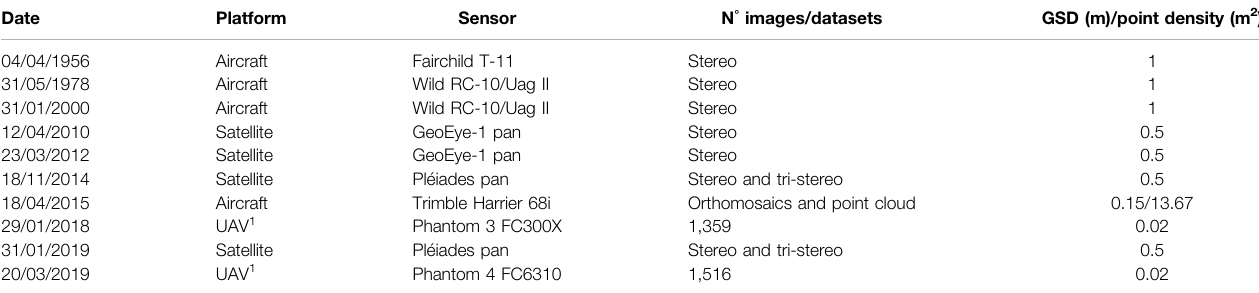
TABLE 1 | Available remote sensing imagery for the study area between 1956 and 2019. Pan refers to the panchromatic bands in GeoEye-1 and Pléiades